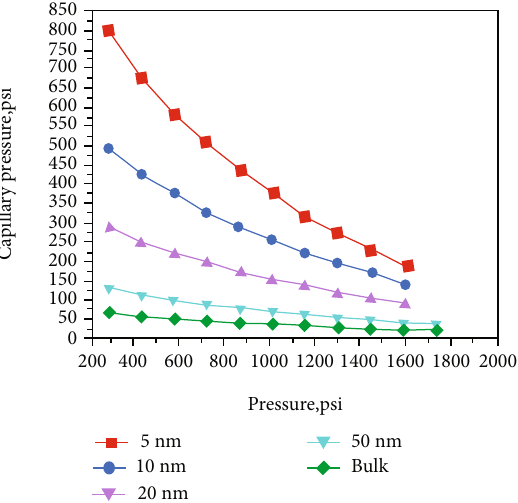
Figure 7: Capillary pressure of the Bakken tight oil versus pressure at various pore radii at T = 230 ° F.